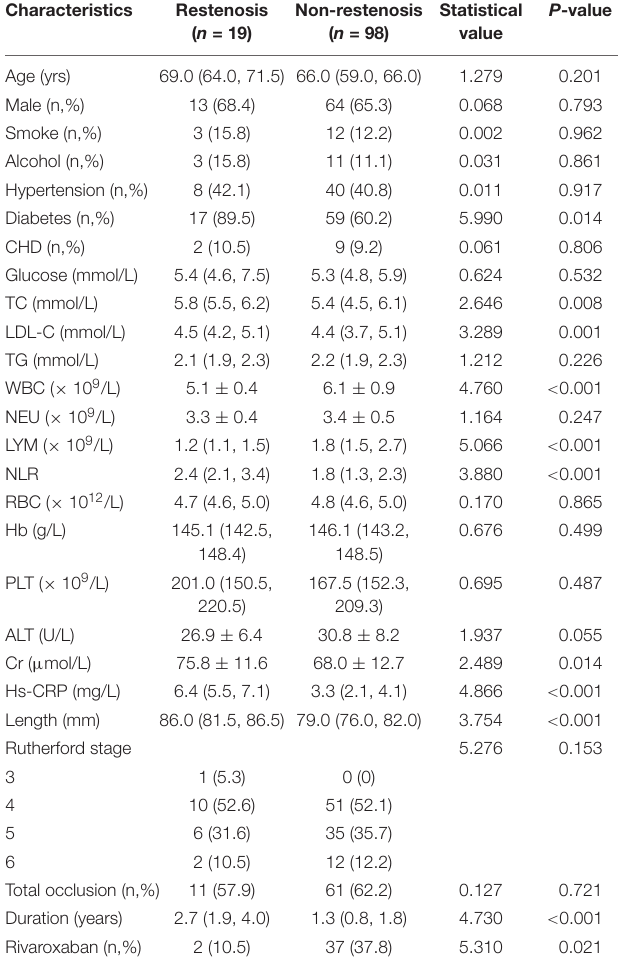
TABLE 3 | Baseline data comparison of patients with restenosis and non-restenosis.